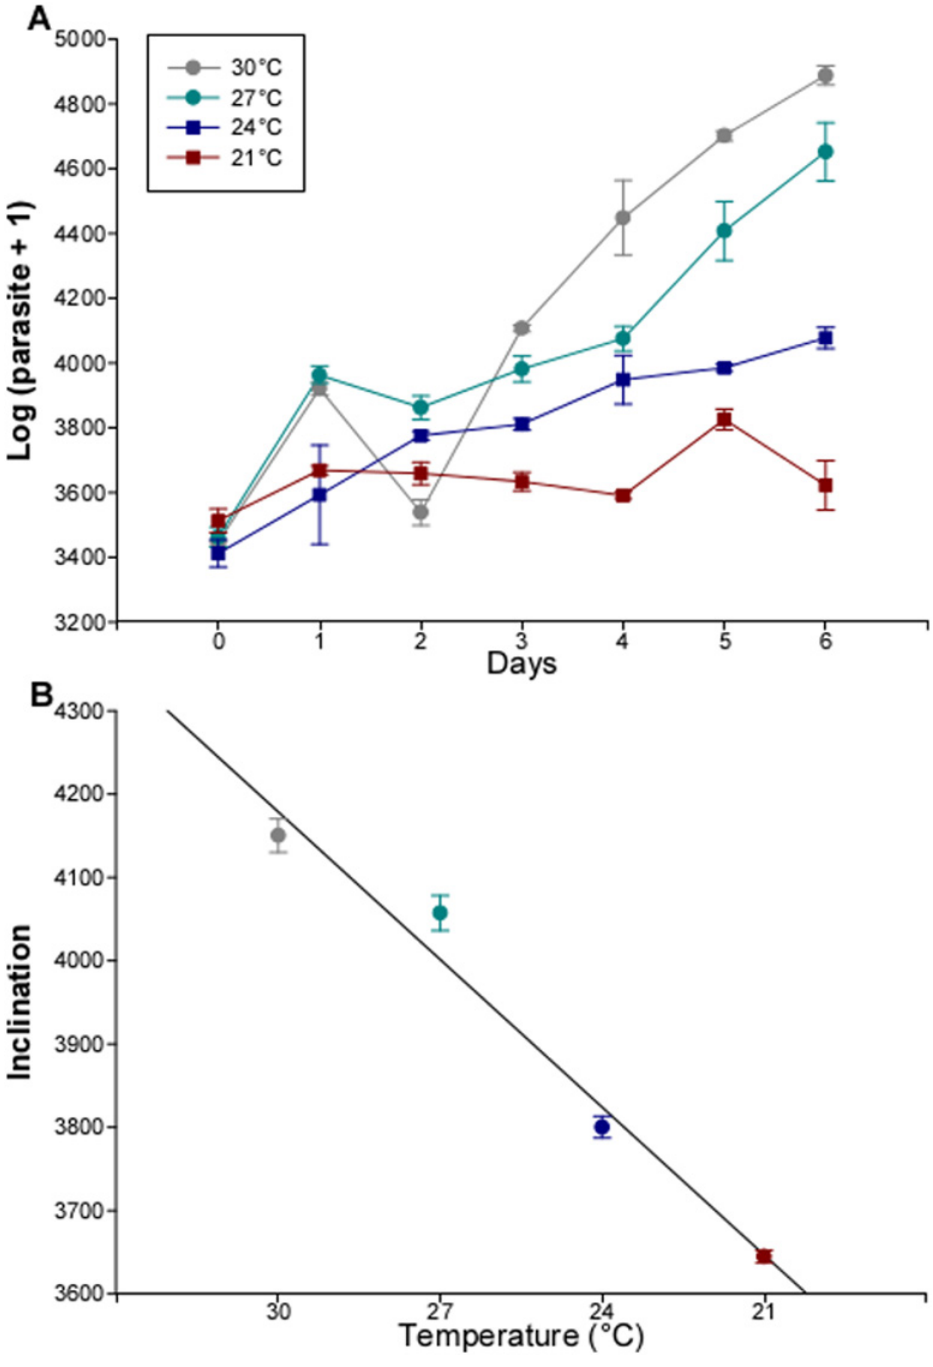
Fig 2. Growth of cultures of Trypanosoma cruzi epimastigotes kept under different temperatures. (A) growth through time (live parasites counted in a flow cytometer after staining with fluorescein diacetate). (B) growth rates with temperature. Error bars are standard errors obtained from two